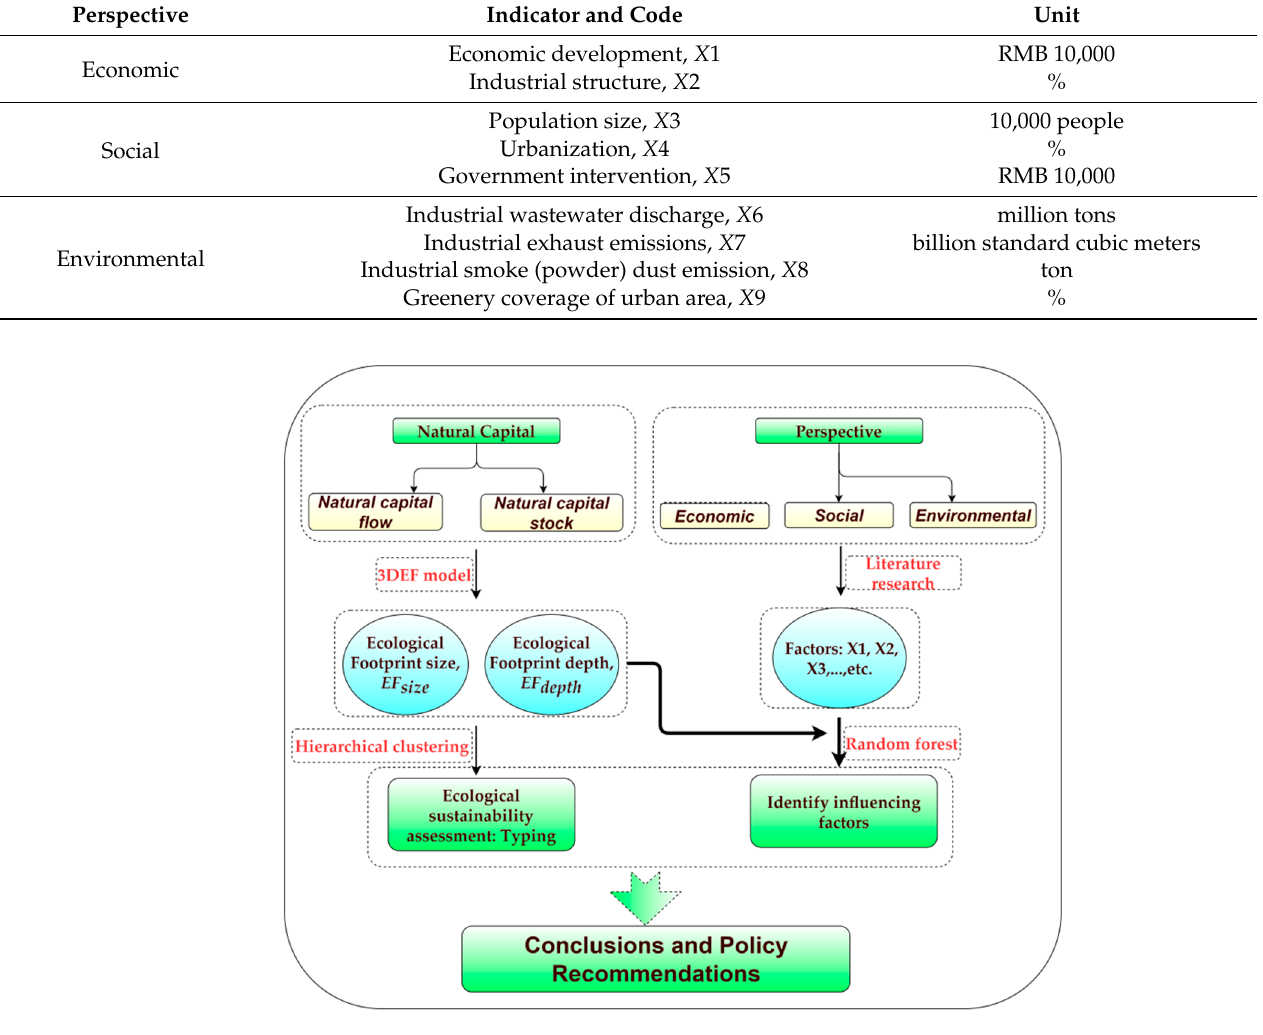
Figure 1. Research